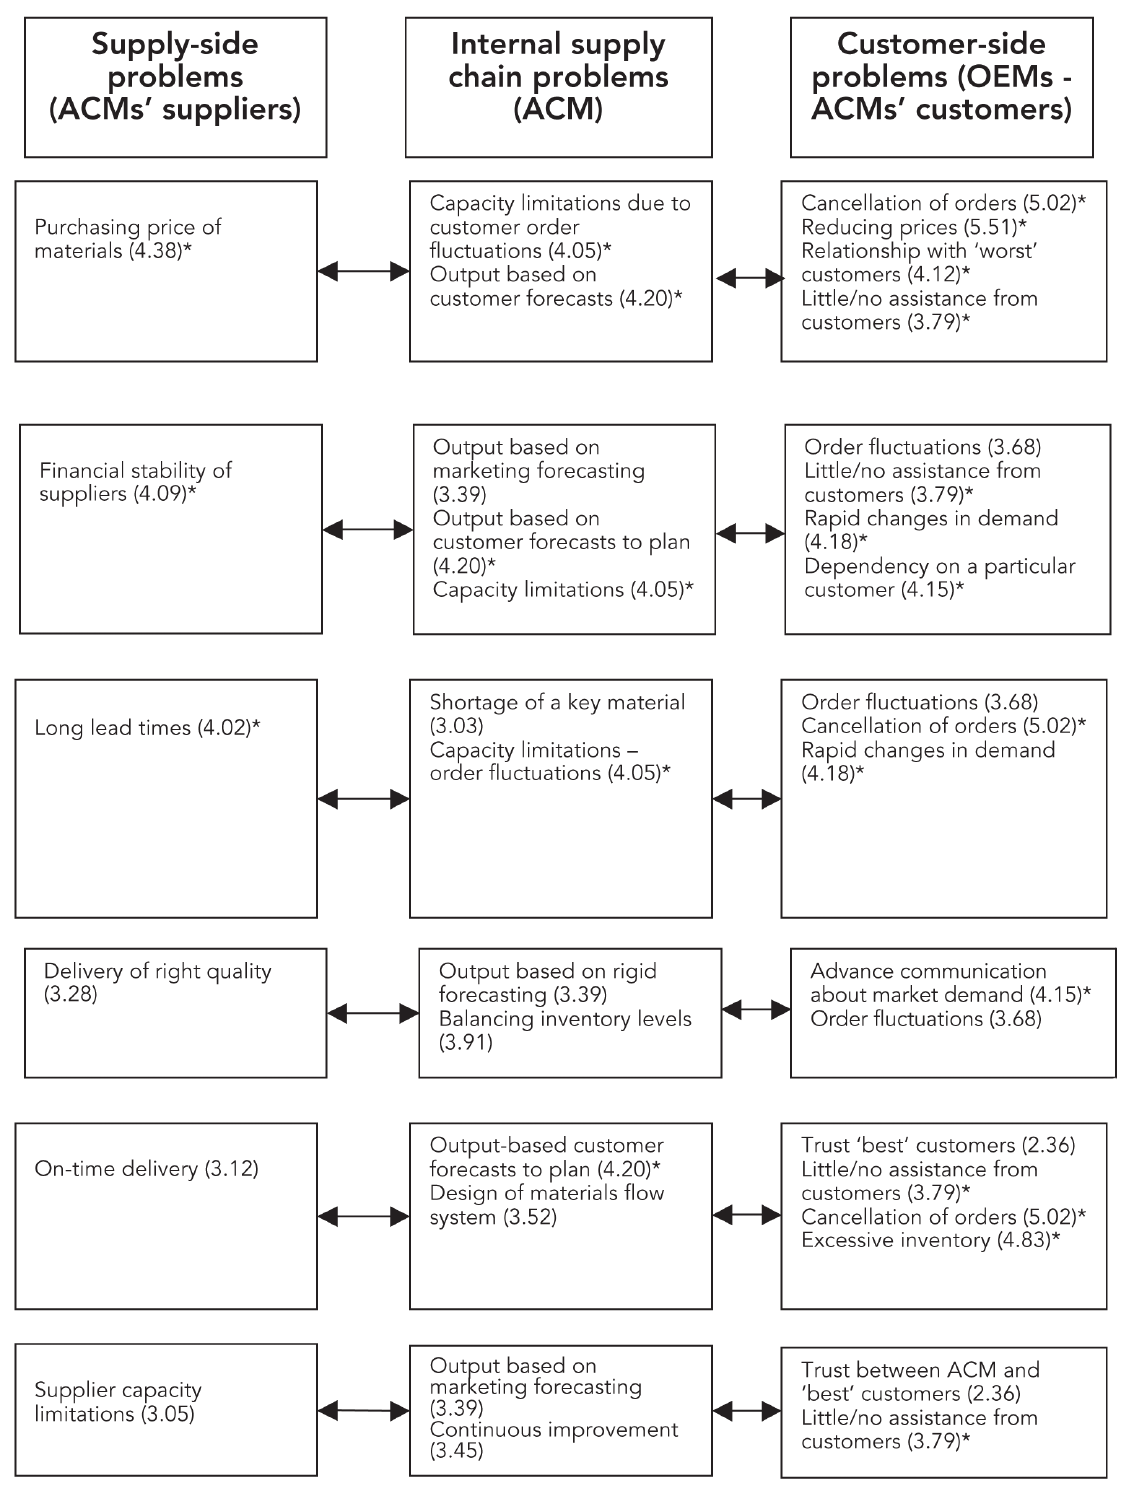
Figure 2: Correlations between supply-side and internal supply chain and customer-side problems 2 (including (mean); *=significant)